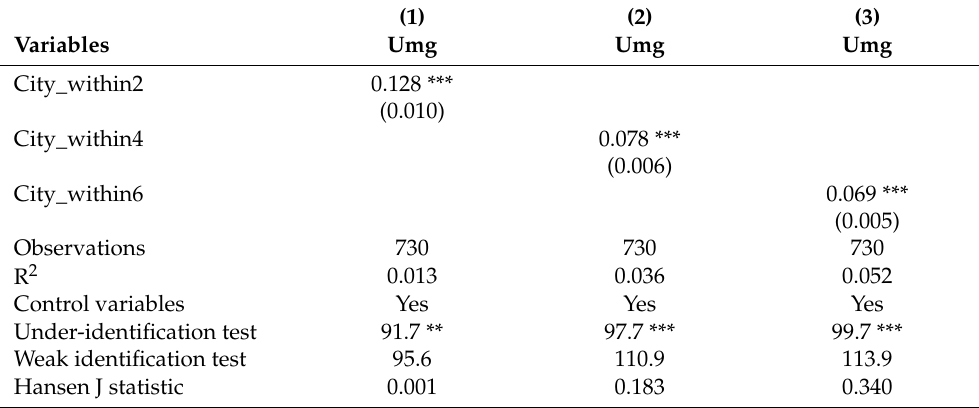
Table 10. The robustness test of the baseline model when dependent variable replaced by utility model patent granted.